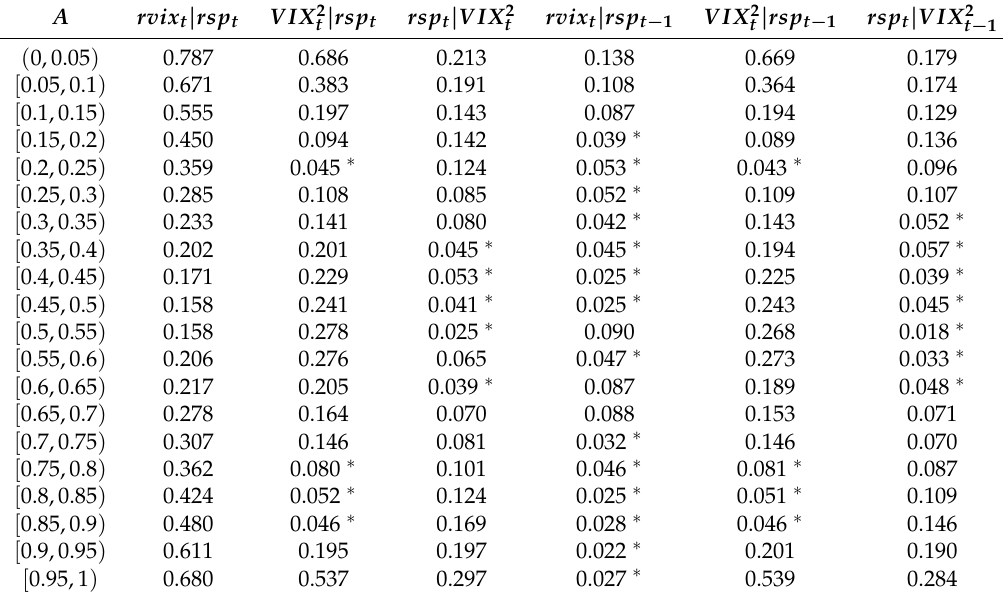
Table 5. Conditional Dependence